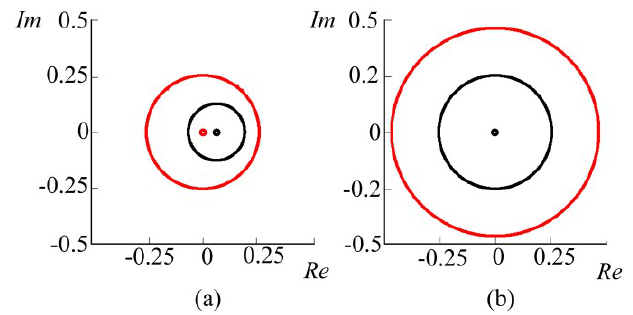
Fig. 10: Real System Transformation (a) Eccentric Plane and (b) Concentric